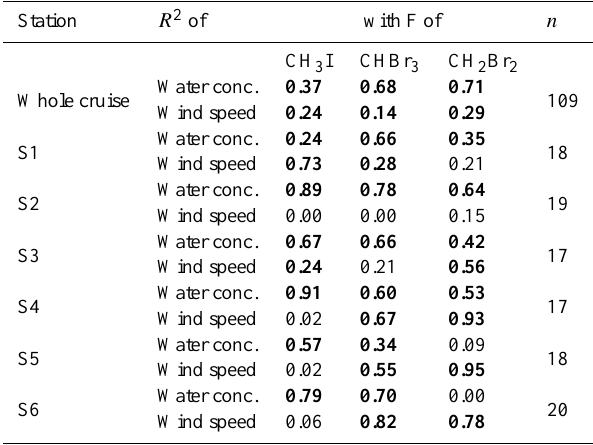
Table 4. Correlation coefficients for water concentrations of halo- carbons and wind speed with sea-to-air fluxes of halocarbons for the whole cruise and for the individual stations. Coefficients printed in bold represent significant correlations with p